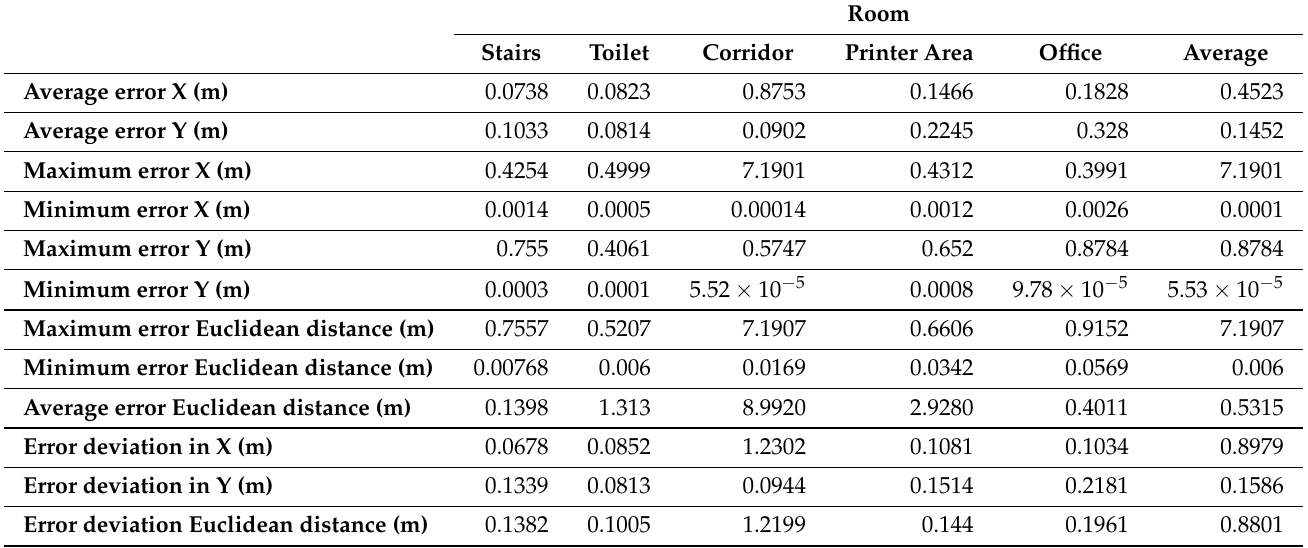
Table 3. Localization results performed by the regression CNNs. Results (errors in the estimation and deviations, as detailed in the left column) are presented separately for coordinate X and coordinate Y and globally for both coordinates (Euclidean